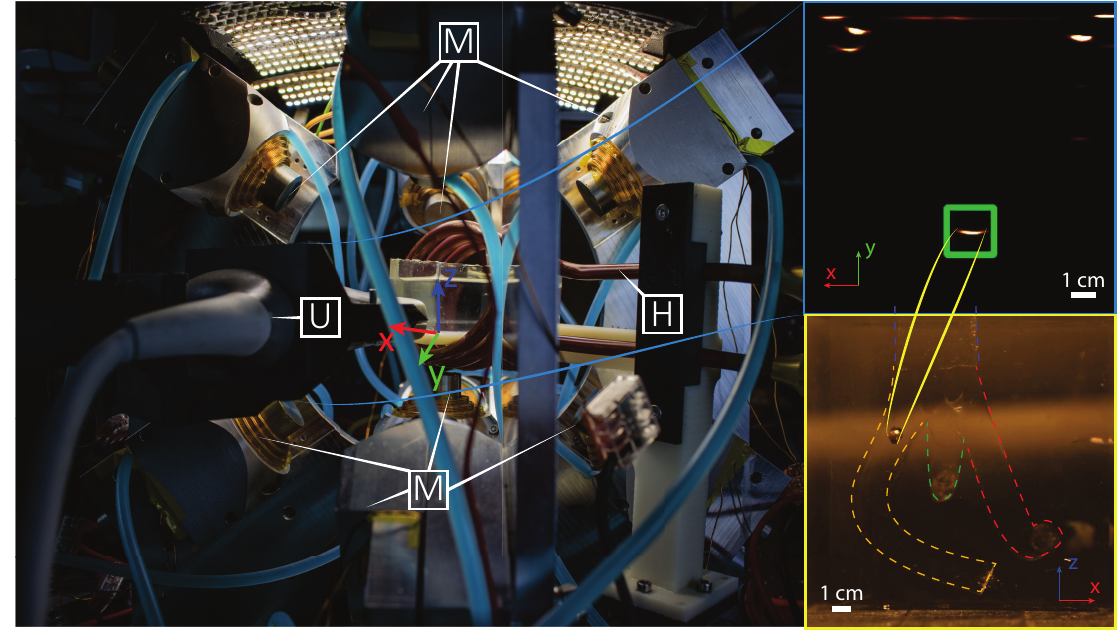
(cid:16) (cid:17) M are capable of 160 mm (cid:16) (cid:17) (cid:31) U along the gravitational axis (z). (cid:16) (cid:17) H can be seen in the right end of the image. ( Top-right